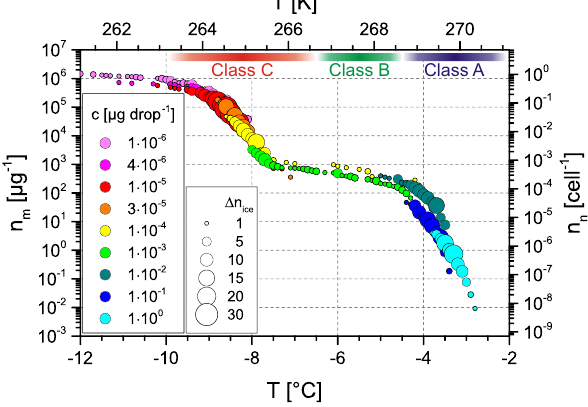
Figure 4. Experimentally determined active site density per unit mass of Snomax ® n m (T ) vs. temperature. Symbol colors indicate data from droplets with different Snomax ® concentrations; symbol size indicates the number of nucleating droplets per temperature in- terval. The temperature range for different classes of INs according to the definition by Turner et al. (1990) are also indicated by the colored bars.